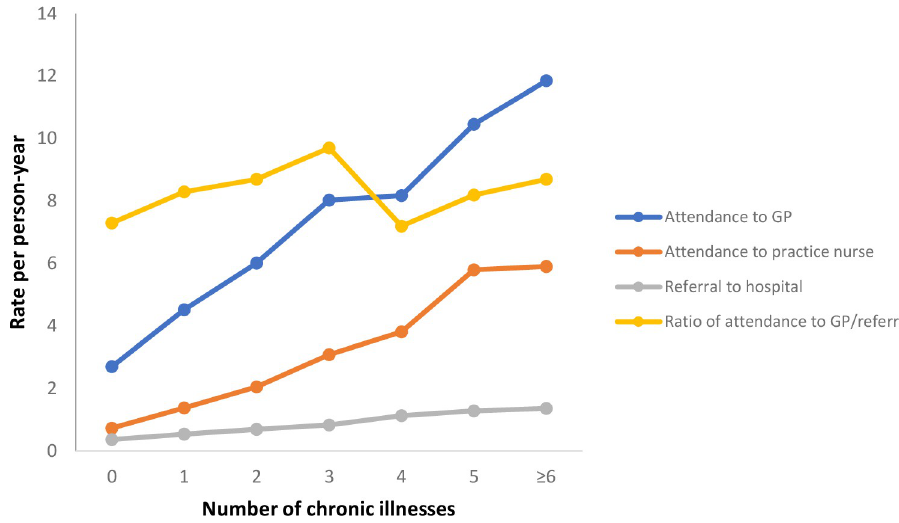
Fig 2. Attendances and referrals by number of chronic